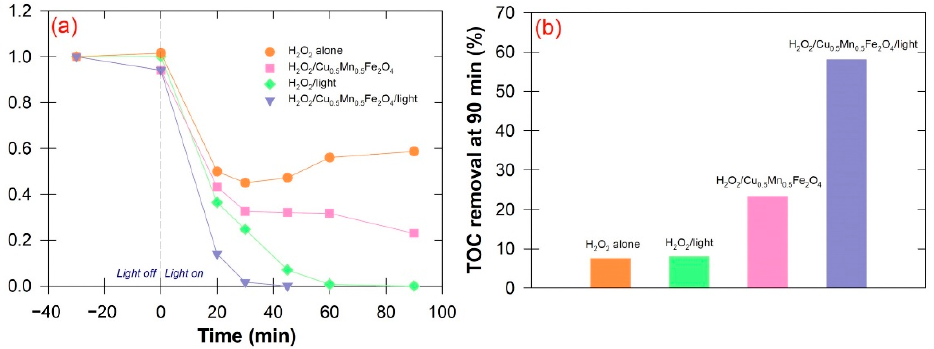
Figure 3. ( a ) Temporal changes in OTC concentration and ( b ) TOC removal efficiency under different conditions (Experimental conditions: [OTC] 0 = 0.1 mM, [H 2 O 2 ] = 97.89 mM, catalyst loading = 0.5 g/L).